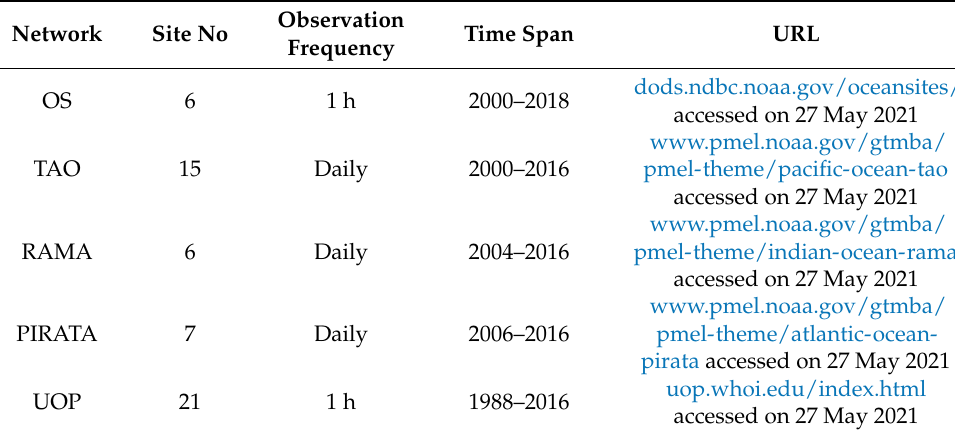
Table 1. Information on the five measuring